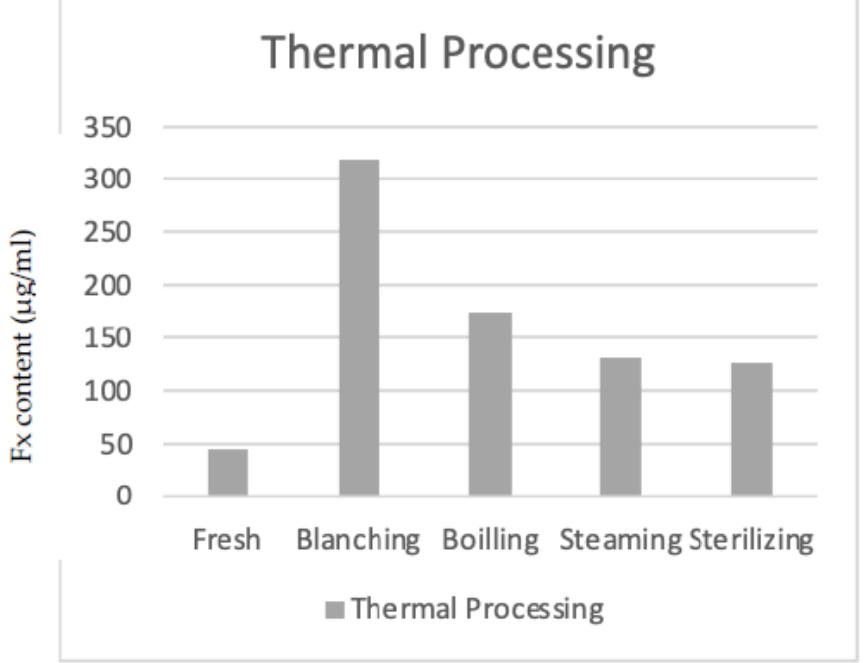
Figure 2. Fucoxanthin content in fresh and thermally processed in S. ilicifolium . Values are express in μg/mL [12].